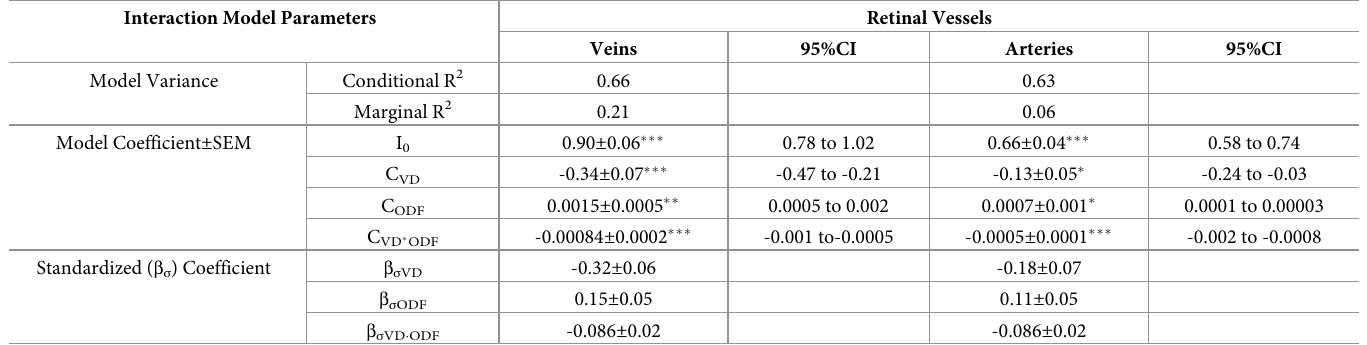
Table 1. Linear mixed effects model with interaction of the